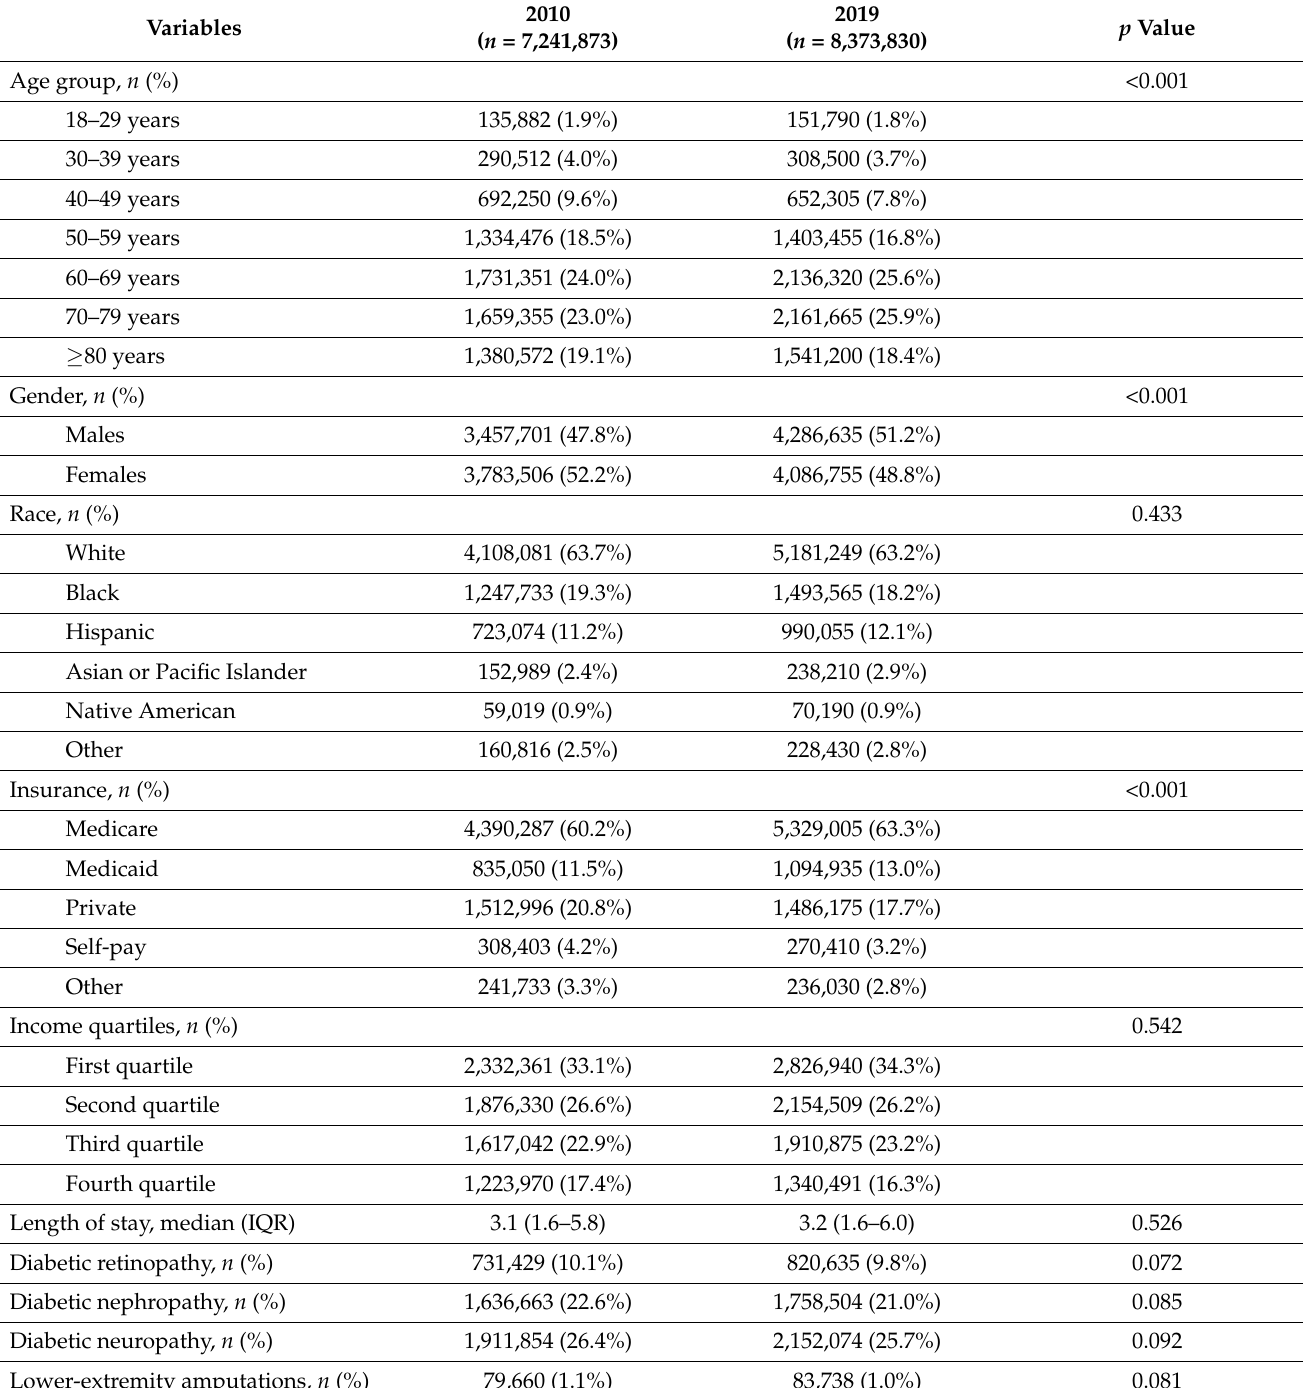
Table 1. Comparison of demographic characteristics of diabetes hospitalizations between 2010 and